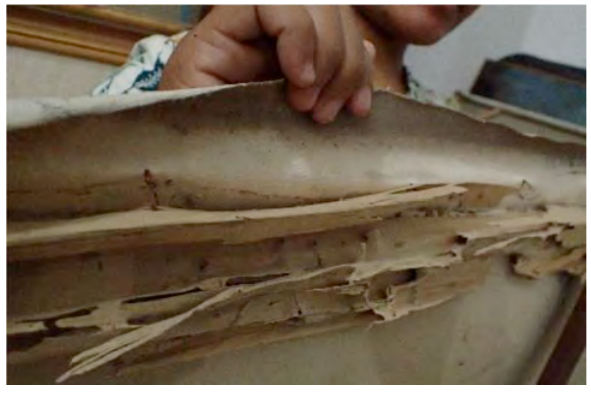
Figure 6: Termite frass in the wooden strechers (P. Engel